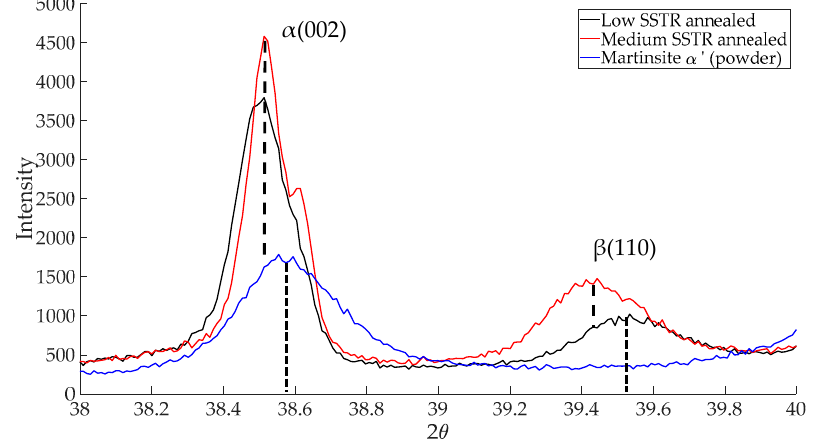
Figure 7. XRD plot of martensitic powder and samples annealed in the low and medium-SSTR.